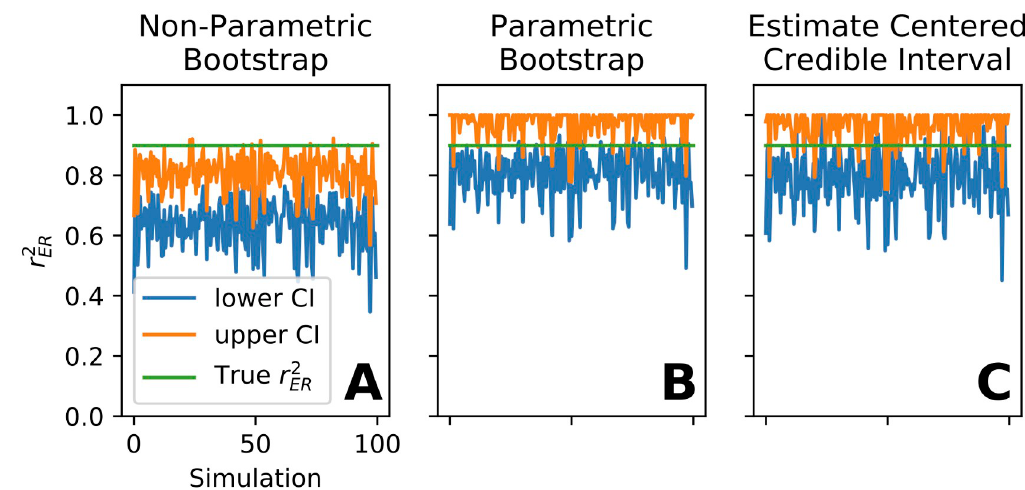
Fig 5. Validation of confidence interval (CI) methods by simulation—example CIs for three methods. Simulation parameters: n = 4, m = 40, true r 2 ¼ 0 : 91 , dynamic range d 2 = 0.25, trial-to-trial variability σ 2 = 0.25, and target confidence ER level α = 0.8. Of 2000 independent simulations, CIs for the first 100 are plotted here for three different methods. CIs for all methods were calculated using the same set of randomly generated responses. (A) For the non-parametric bootstrap method, the upper end (orange) and lower end (blue) of the CI were almost always both below the true correlation value (0.91, green line), indicating an overwhelming failure to achieve 80% containment of the true value. (B) The parametric bootstrap method and (C) our ECCI method perform substantially better. Performance of all three methods over the full range of true r 2 plotted in Fig 6.